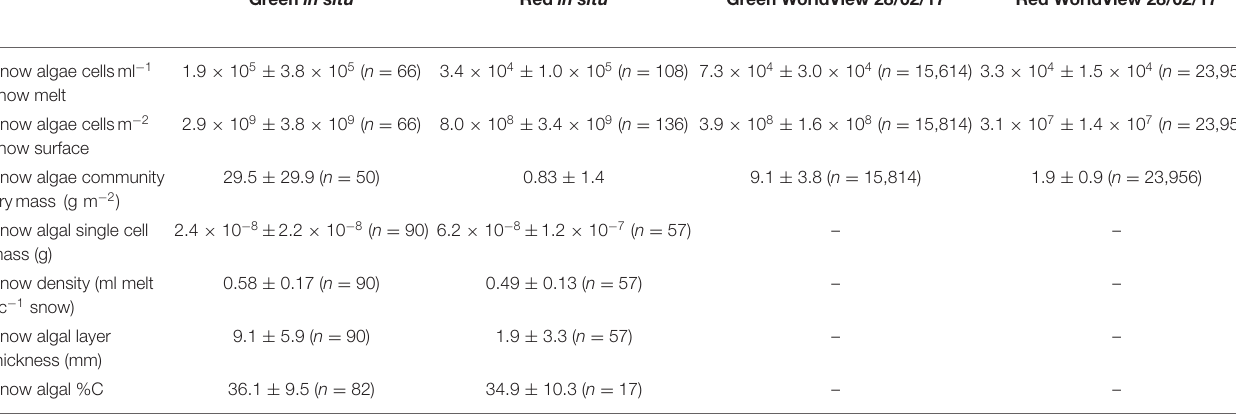
Pit sampling revealed green layers turning red in some instances ( Figure 2C ), although red blooms mostly appeared on the top of fresh snow, with no green cells detected within the underlying